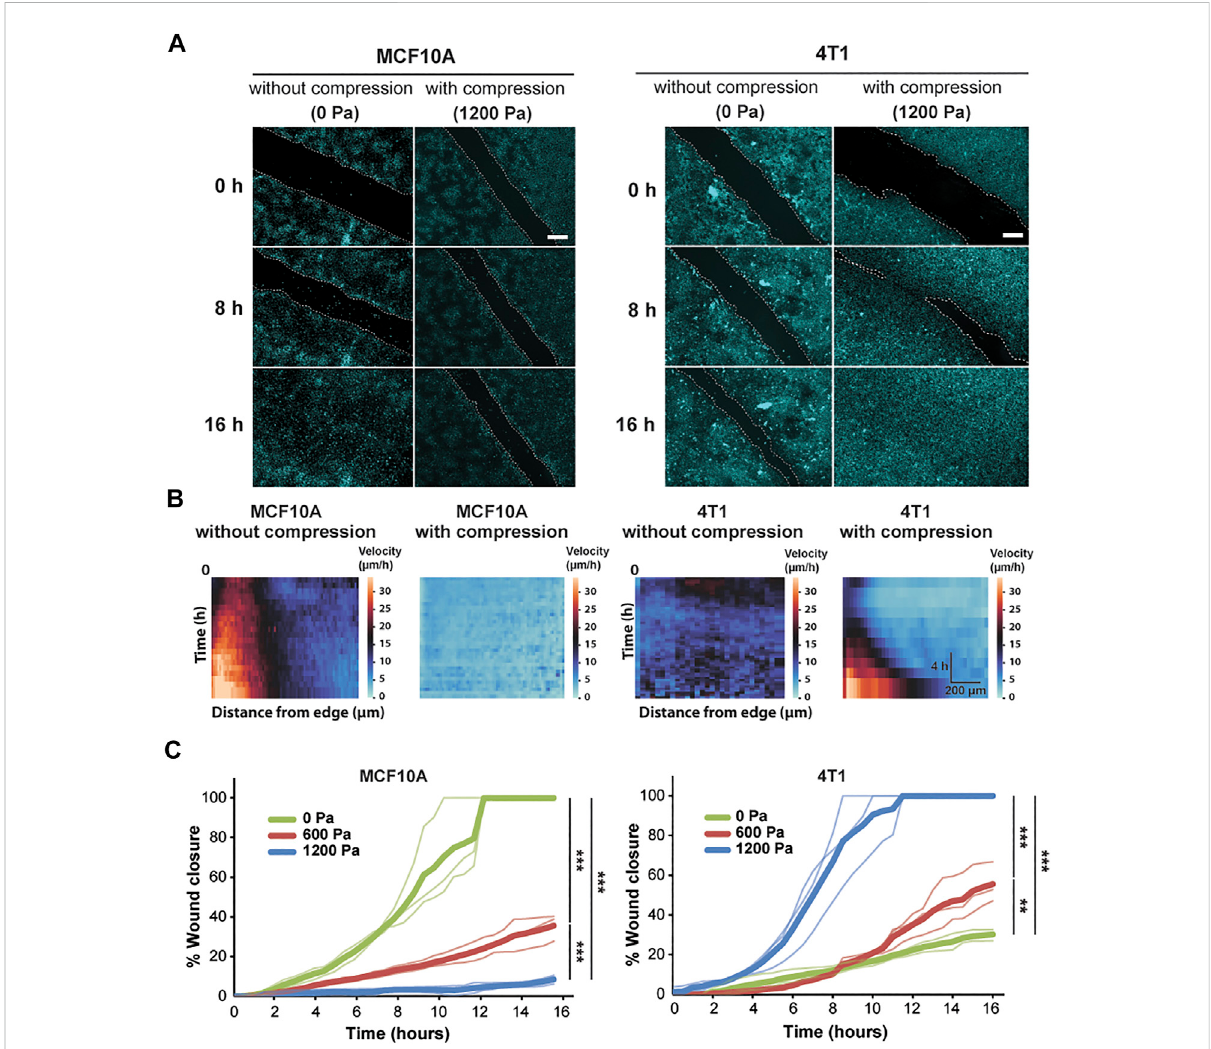
FIGURE 1 Compressive stress inhibits migration in MCF10A cells and enhances migration in 4T1 cells. (A) Representative fl uorescence imagesof MCF10A and 4T1 wound areas at the indicated time points post-wound with and without compression. Cell nuclei are labeled with Hoechst 33342. Lines are scratched on each well using a p-200 pipette tip and cell migration is captured by fl uorescence microscopy at 30-min time intervals for 16 h post- wound. Cell edges used to calculate wound area are outlined by white dashed lines. Scale bars, 200 µm. (B) Heat maps show spatiotemporal evolutionofthevelocityforcontrolandcompressedcells. (C) Quanti fi cationofwoundarea(betweenwhitedashedcelledges)foreachcelltypeand compressive pressure. Mean wound area at each time point is plotted from three independent replicates with the individual experiments plotted as thin